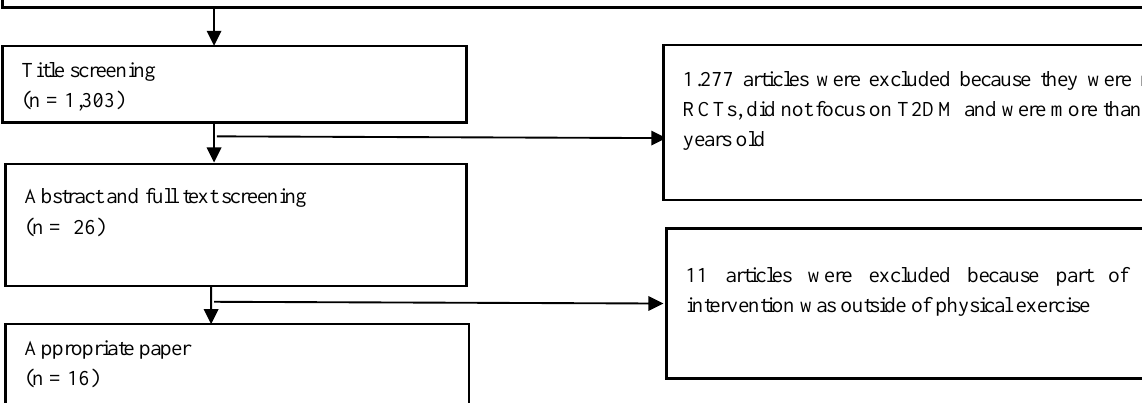
Figure 1 – Flowchart for the search and selection of the